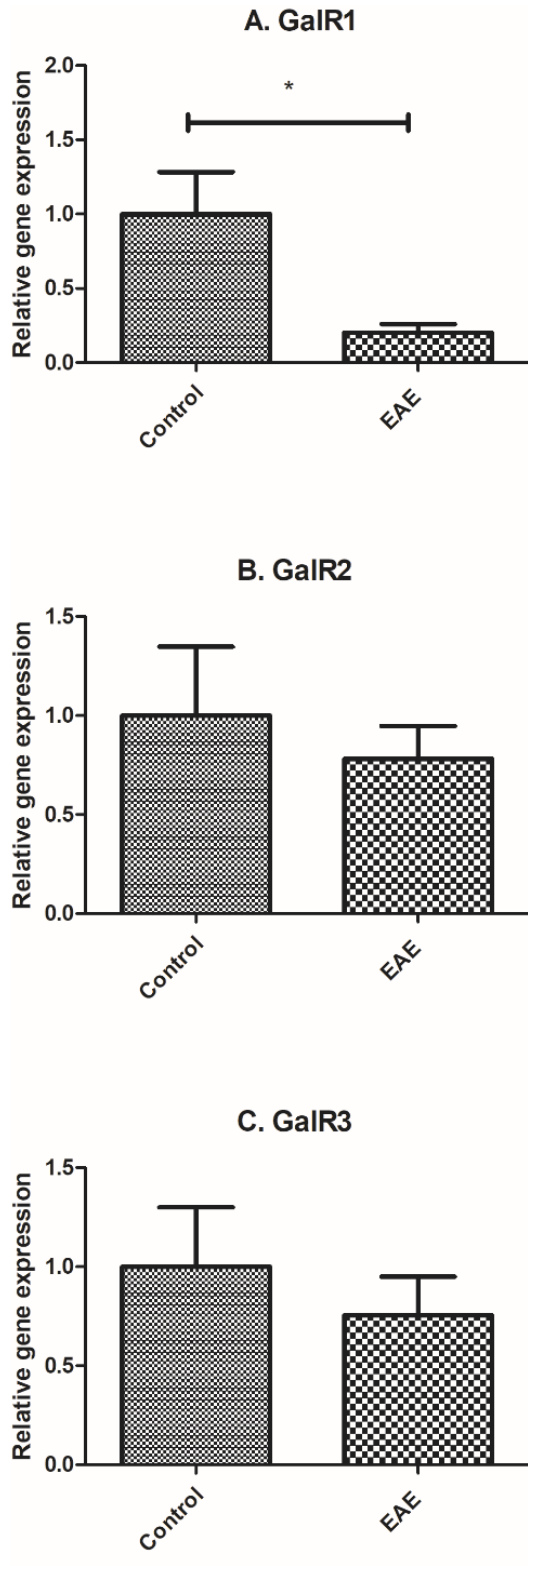
Fig. 1. Expression of galanin receptors in spinal cord in the con- trol and experimental autoimmune encephalomyelitis (EAE) mice. Relative gene expression of A. galanin receptor 1; B. galanin receptor 2; C. galanin receptor 3. Results are presented as mean ± SD (n = 12 samples in the EAE and 14 samples in the control group), * P